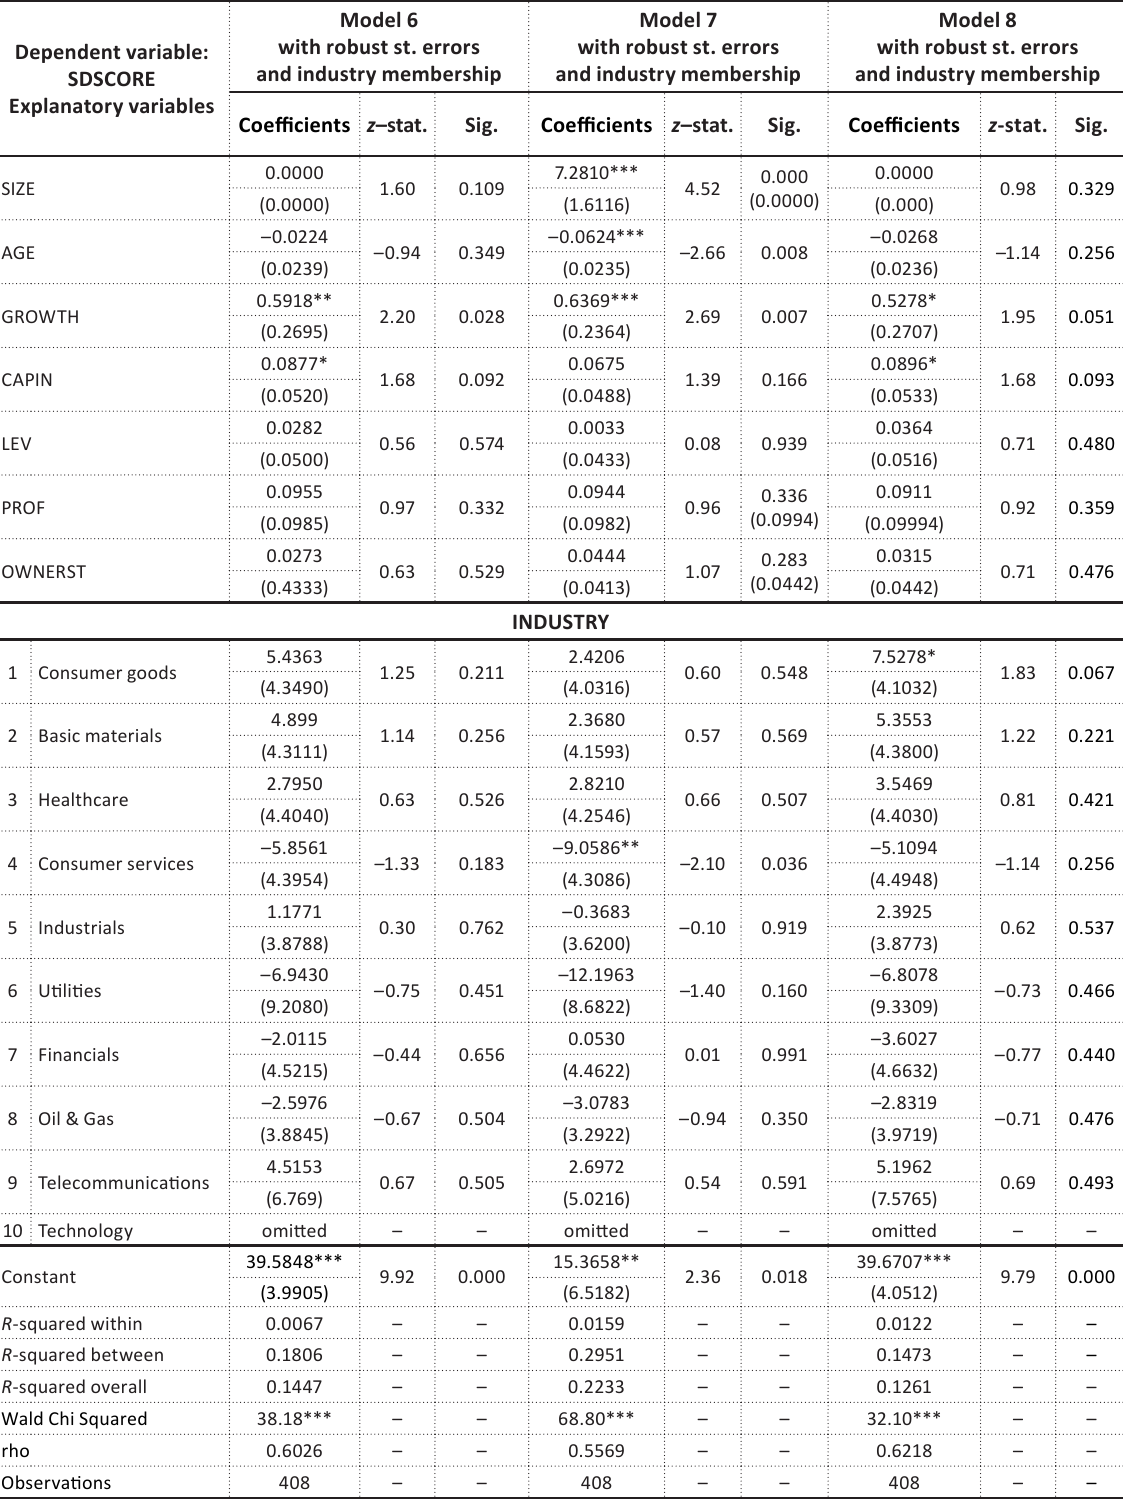
Table 7. Robustness check 3: regression models with different proxies for firm size including control